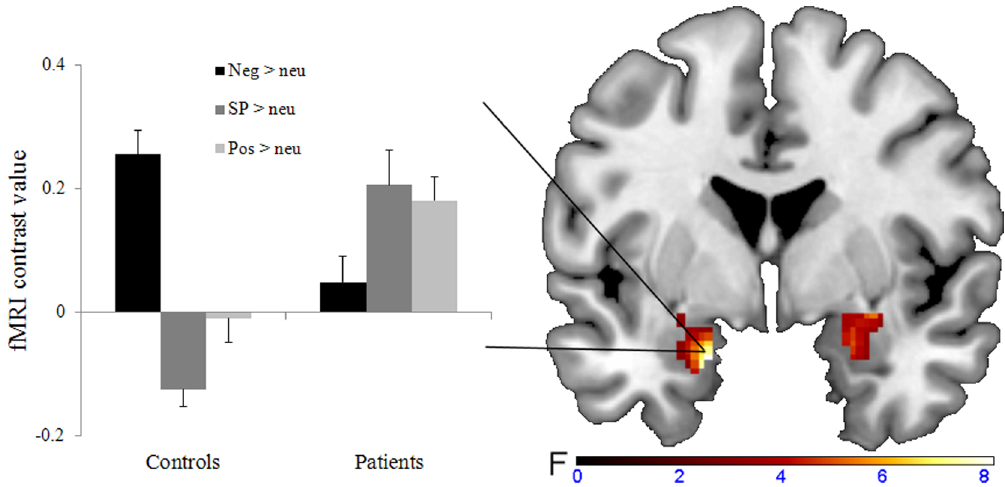
Figure 1. Region of interest analysis of the amygdala. Left: bar graphs depicting the mean contrast value for negative, SP-related, and positive versus neutral words extracted from x= 2 18, y=0, z= 2 24. Error bars, SEM. Right: coronal view (y=0), depicting the significant group x word category interaction in the bilateral amygdala.